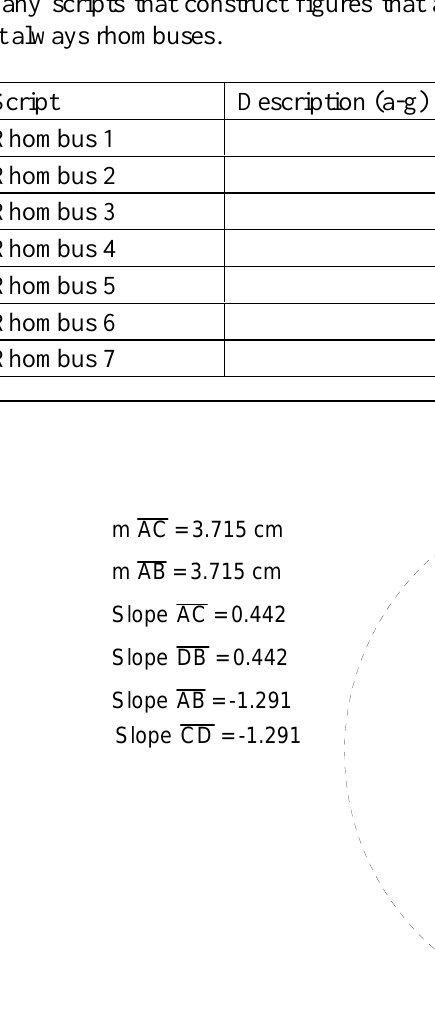
A Figure 1: Example of an on-screen sketch